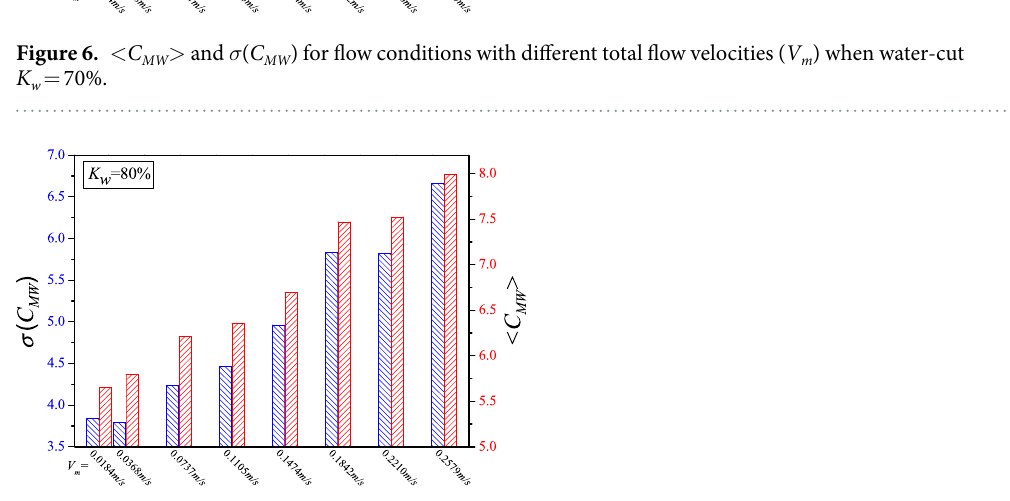
Figure 7. < C MW > and σ ( C MW ) for flow conditions with different total flow velocities ( V m ) when water-cut K w =